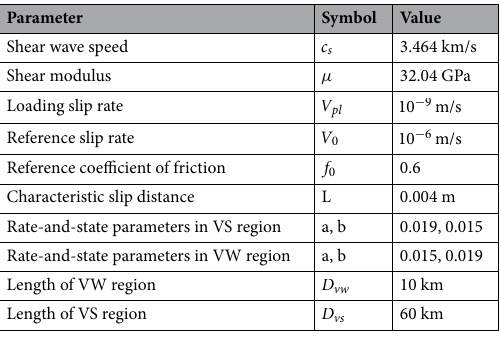
Table 1. Commonly used parameters in the numerical simulations in this